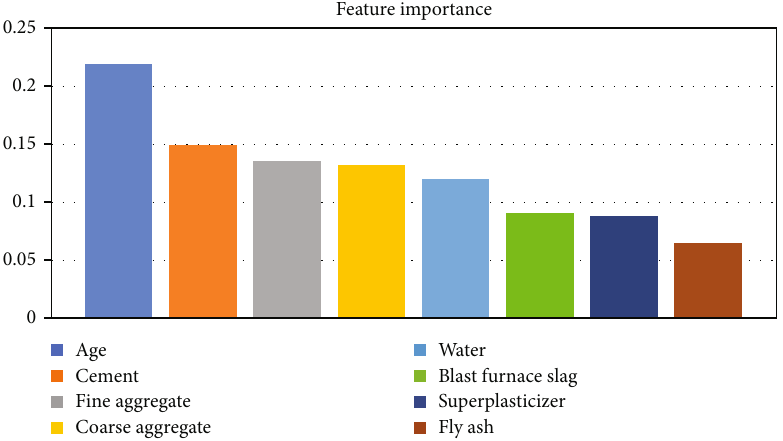
Figure 11: Feature importance ranking.